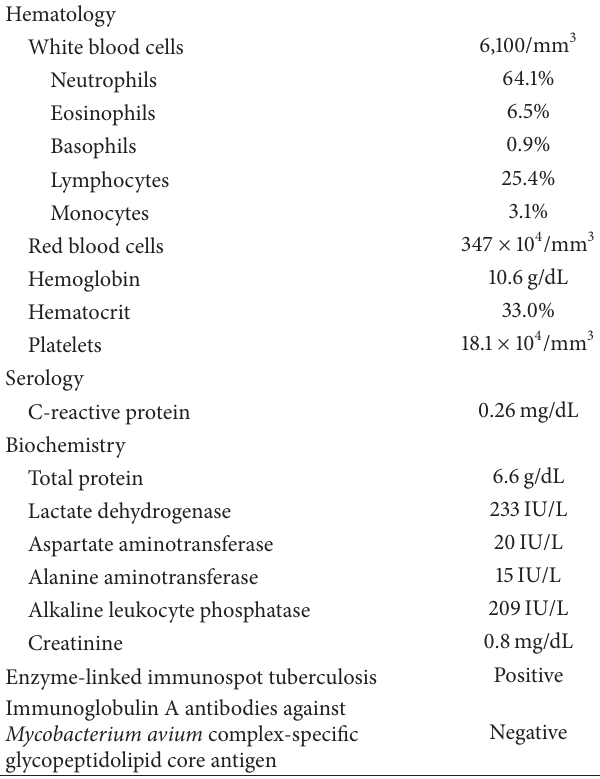
Table 1: Laboratory data on initial